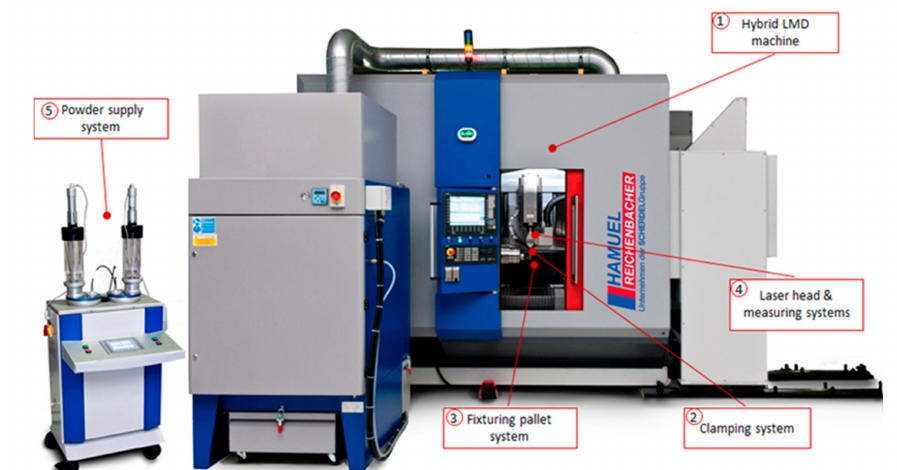
Figure 2. LMD pilot cell at AUTODESK Technology Centre in Birmingham, England. (1) Hybrid machine (HAMUEL HSTM 150 HD), (2) Clamping system (EROWA PC210), (3) Fixturing pallet system (EROWA), (4) Laser head and measuring systems, (5) Powder feeder